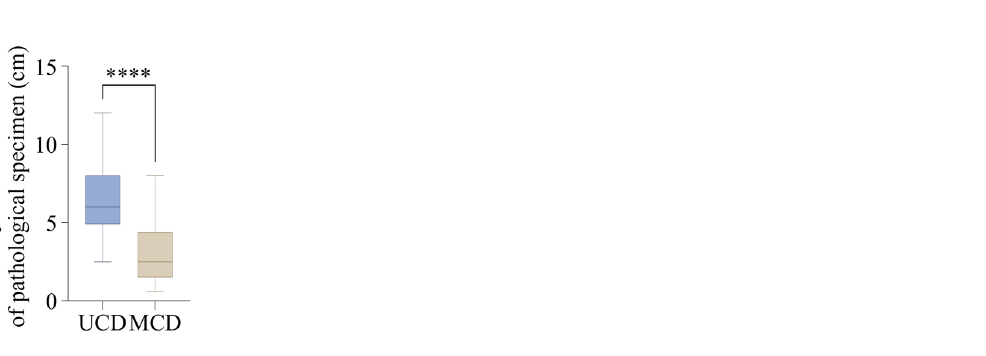
Figure 3. Pathological findings. The major diameters of pathological specimens (cm) of UCD and MCD patients. ****P < 0.0001 as determined by two-tailed Student’s t